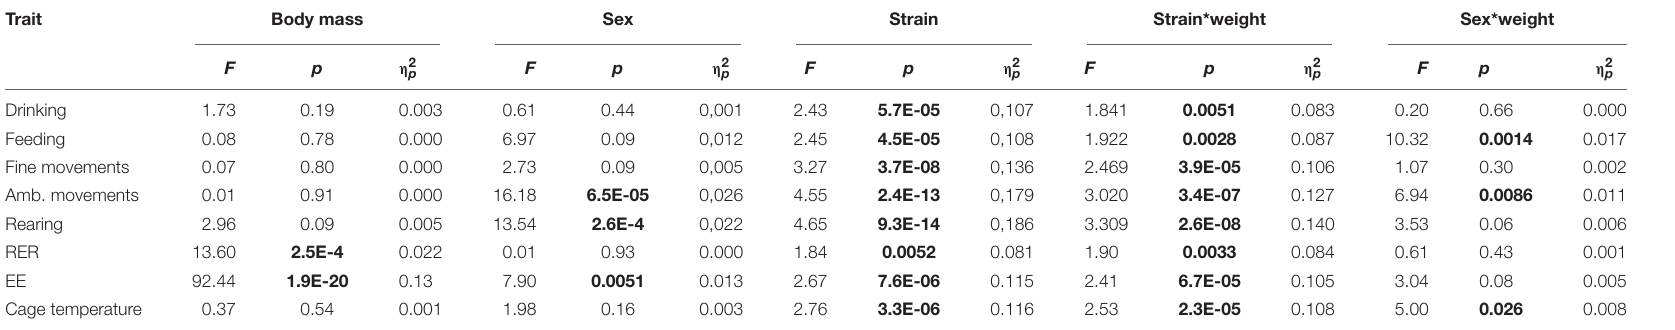
TABLE 2B | Strain and body weight interaction are present in activity traits and EE.